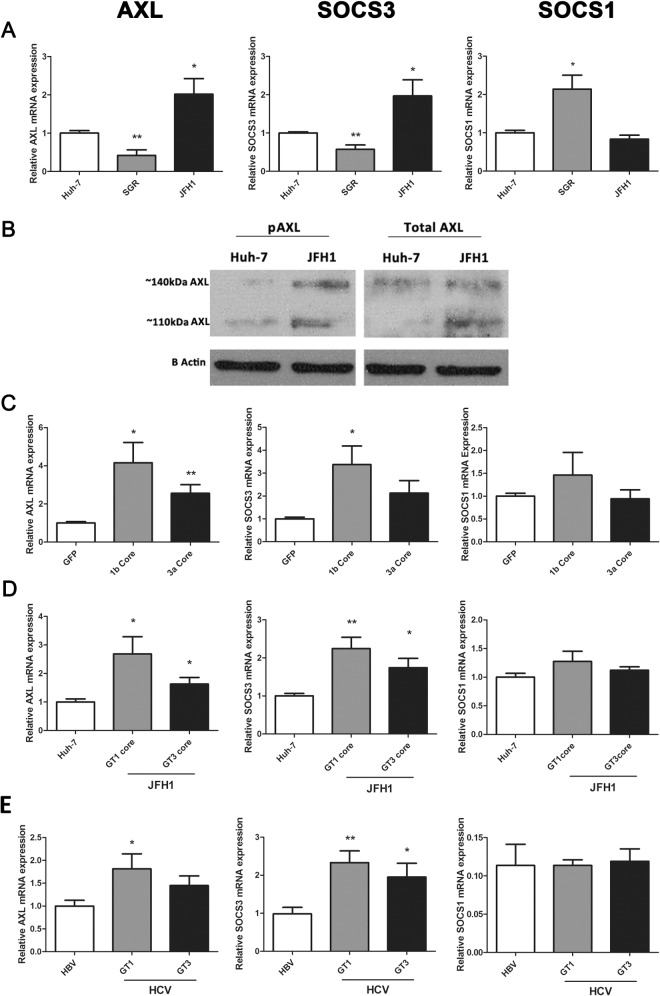
HCV infection mediates AXL expression in vitro and in vivo.
AXL and SOCS3 expression are significantly increased in JFH1 infected Huh-7 cells, but decreased in cells containing a genotype 2a HCV subgenomic replicon (SGR), which lacks structural proteins. This was demonstrated at the mRNA level by qPCR (A), and confirmed at the protein level by western blot (B). Genotype dependent (GT1>3) induction of AXL and SOCS3 was observed in HepG2 cells transfected with baculovirus expressing HCV core protein (C), as well as in Huh-7 cells infected with core chimeric HCV viruses (D) (* p<0.05, ** p<0.01). Data represents the mean and standard error of three biological replicates, each with duplicate samples.